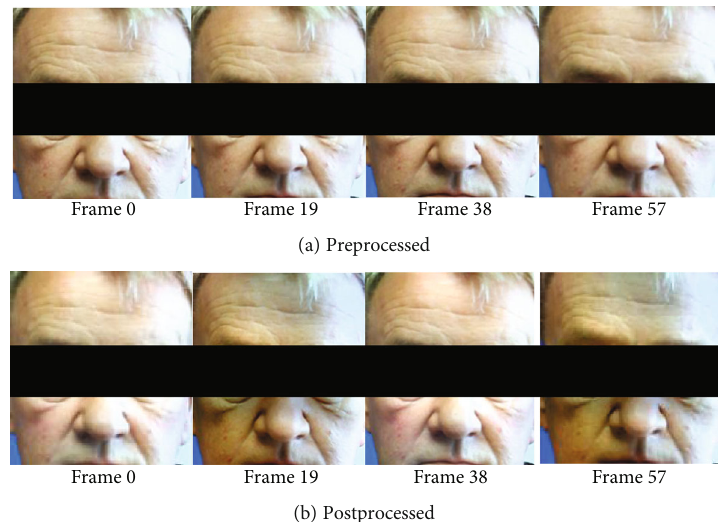
Figure 1: An example of a pre- and postprocessed video in a diabetic patient. Four frames from the original video sequence (a) and the same four frames with the subject ’ s pulse signal ampli fi ed with magni fi cation factor α = 100 (b).